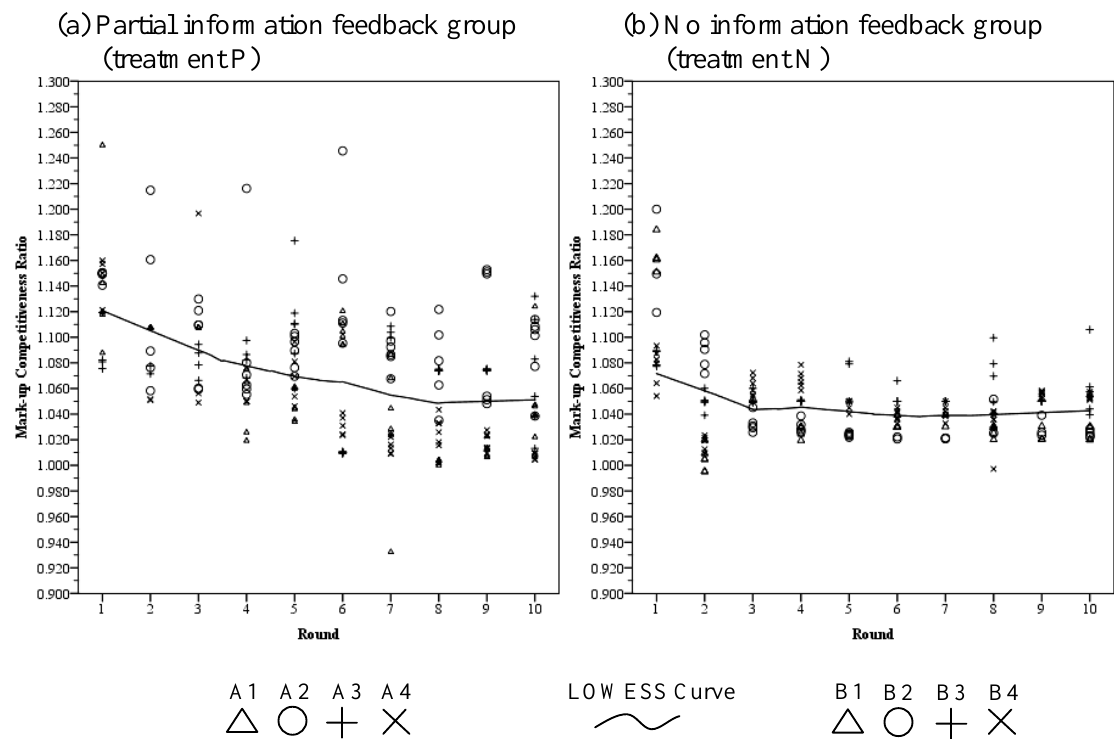
Figure 1 MUCR scatter plots for partial and no information feedback groups Round Subseries Mean Rank N